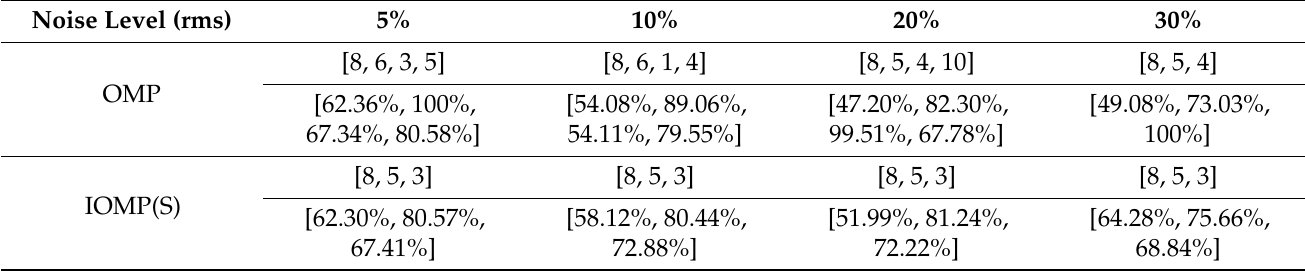
Table 2. The order and identification result of selected damaged substructures under different level